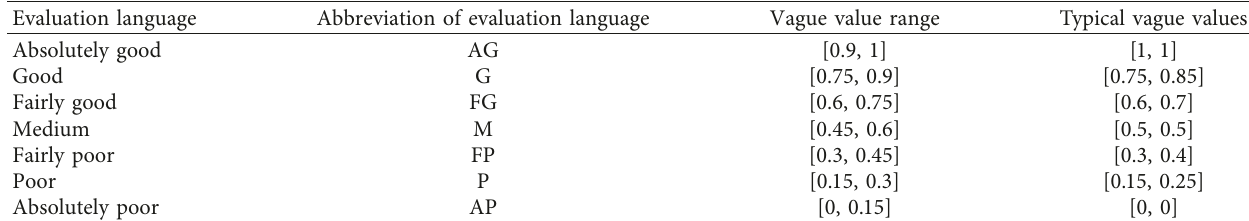
Table 1: Vague values for seven-level language scores.